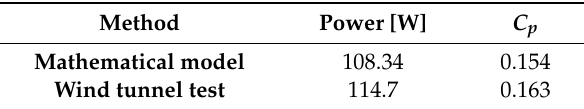
Table 7. Power output and power coefficient obtained from the mathematical model and wind tunnel